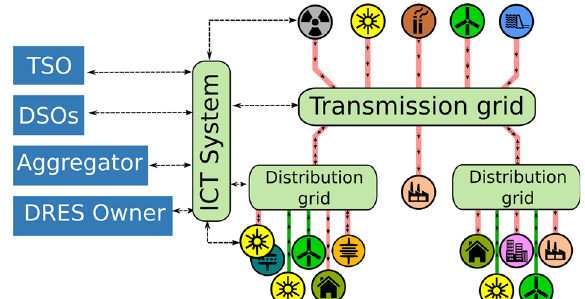
Fig. 1 Schematic representation of the future smart